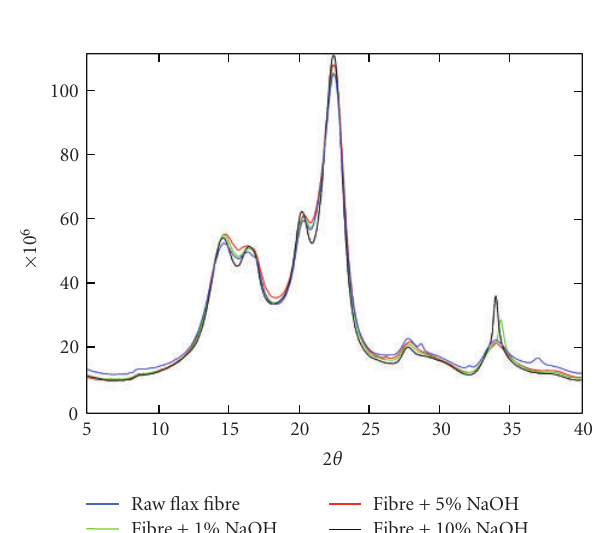
Figure 6: WAXS pattern of raw and di ff erent NaOH-treated flax